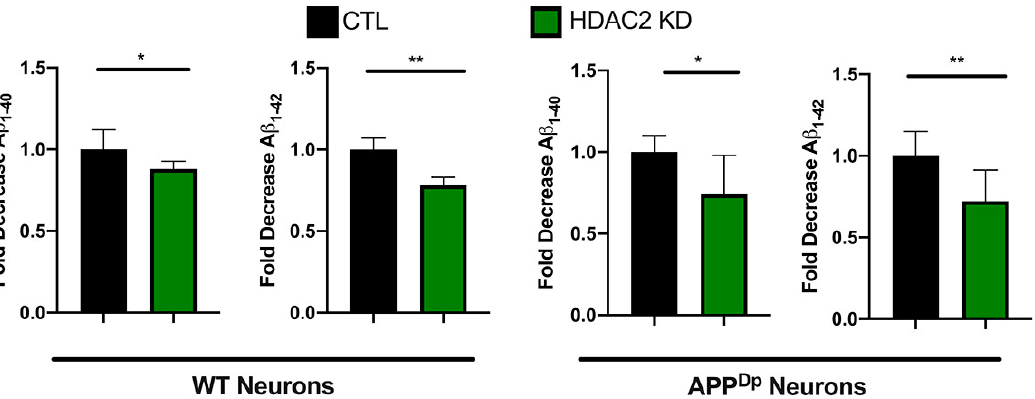
Figure 8. Knock-down of HDAC2 reduces A β peptides in hiPSC-Ns. A β peptides (1–40 and 1–42) secreted in the media from both WT and APP Dp hiPSC-Ns were reduced under HDAC2 knock-down conditions. The data represent two independent differentiations, CTL vs. HDAC2 KD analyzed by t -test ** p < 0.01; * p < 0.05.